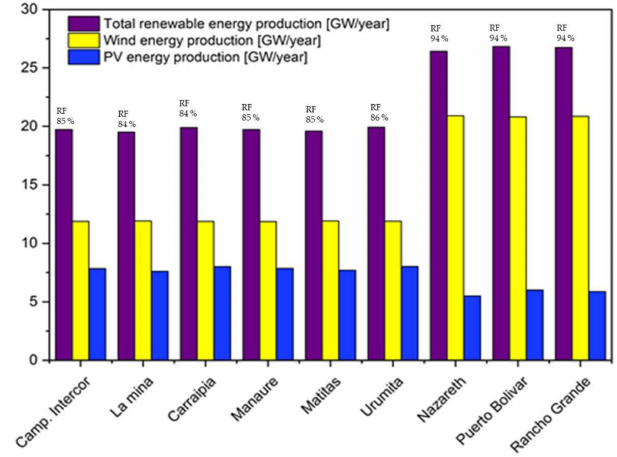
Figure 9. Comparison between the production and renewable fraction for each location.